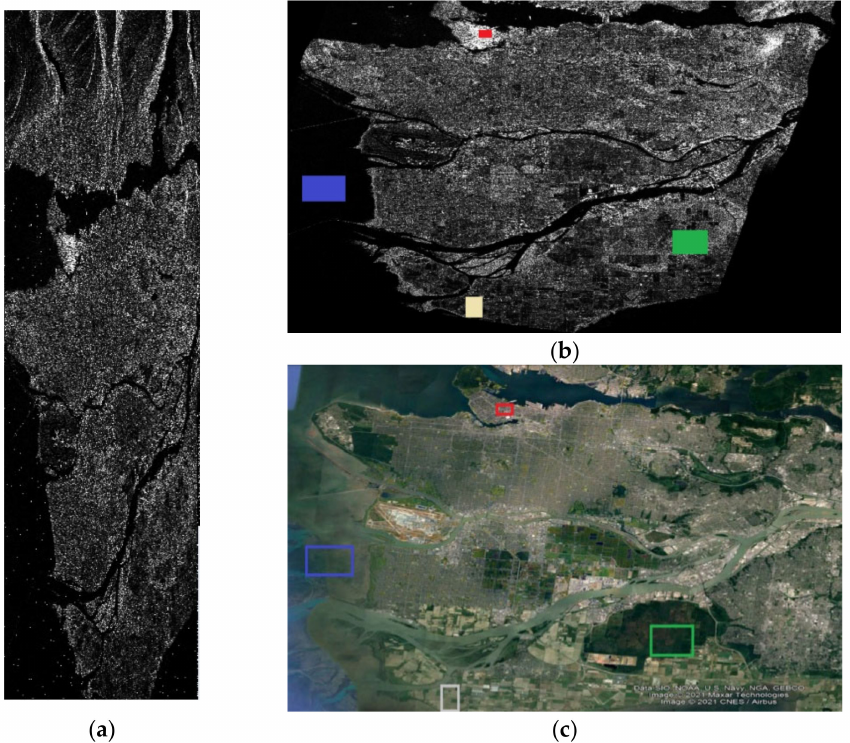
Figure 6. ( a ) Radar slant range perpendicular to the track of the sensor. ( b ) Polarimetric SAR from the wider Vancouver region, Canada (Magnitude of the HV channel). Blue marked region corresponds to water, green to forest/wooded area, red corresponds to urban/built-up area and beige to agriculture/pasture land cover. ( c ) The same region from Google